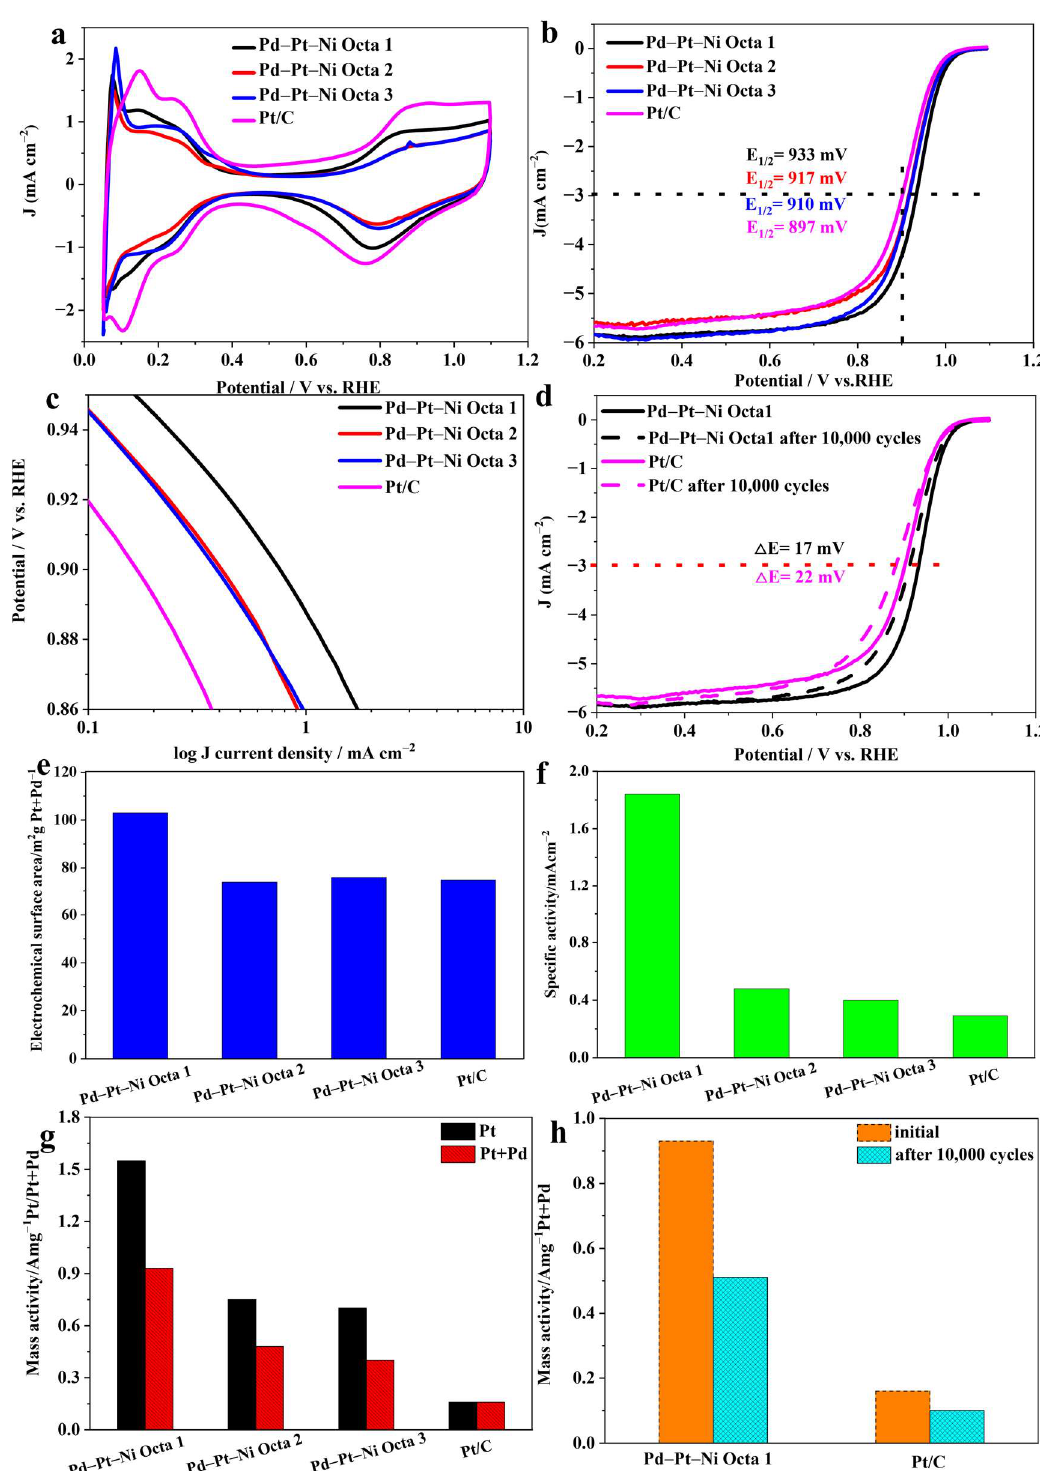
Figure 6. Electrochemical ORR properties of the Pd-Pt-Ni Octa1, Pd-Pt-Ni Octa2, Pd-Pt-Ni Octa3, and Pt/C: ( a ) CV curves in 0.1 M HClO 4 ; ( b ) LSV polarization curves recorded at 10 mV s −1 ; ( c ) Tafel slopes; ( d ) LSV polarization curves of Pd-Pt-Ni Octa1 and commercial Pt/C before and after scanning 10,000 cycles; ( e ) electrochemical surface area (ECSA) comparison; ( f ) specific activity (SA) comparison of the four catalysts; ( g ) mass activity (MA) comparison; ( h ) performance comparison with commercial Pt/C after scanning 10,000 cycles.